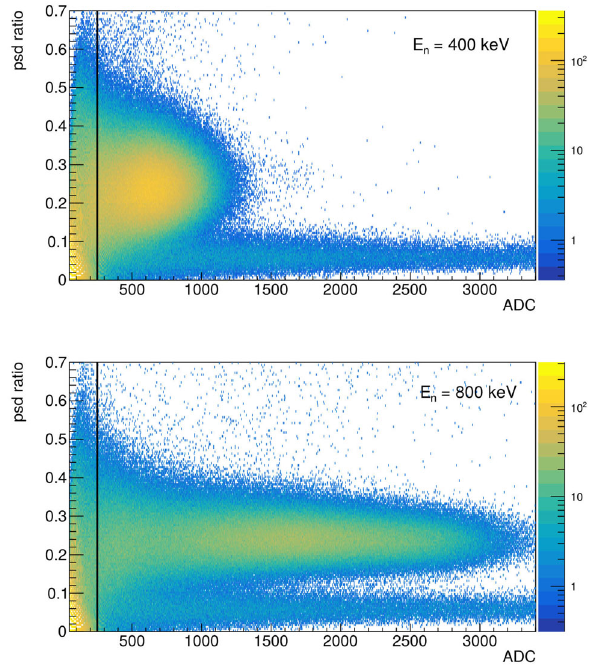
Fig. 6 PSD ratioversus charge (inADC units)for a LS detectorplaced intheneutronbeamlineduringcommissioning.Theblacklineindicates thethresholdusedfortheanalysis.Theneutrons,inducingprotonrecoils in the liquid, are identifiable by their high PSD ratio ( (cid:3) 0.1). The lower band consists of interactions from ambient γ -rays